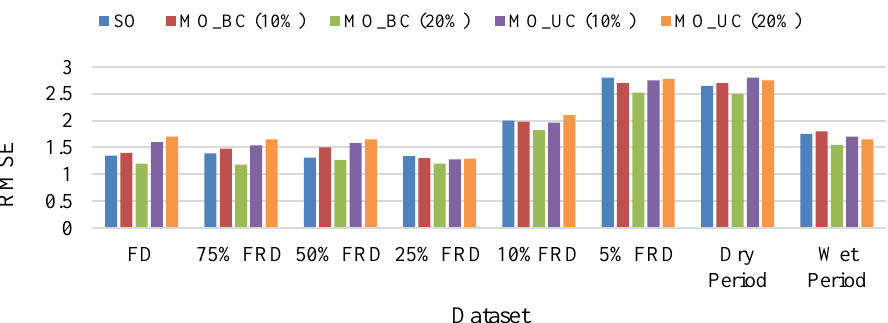
Figure 10. NSE values of different models using five datasets via two main calibration approaches (SO & 4 algorithms parameterization of MO-SB) for each dataset.